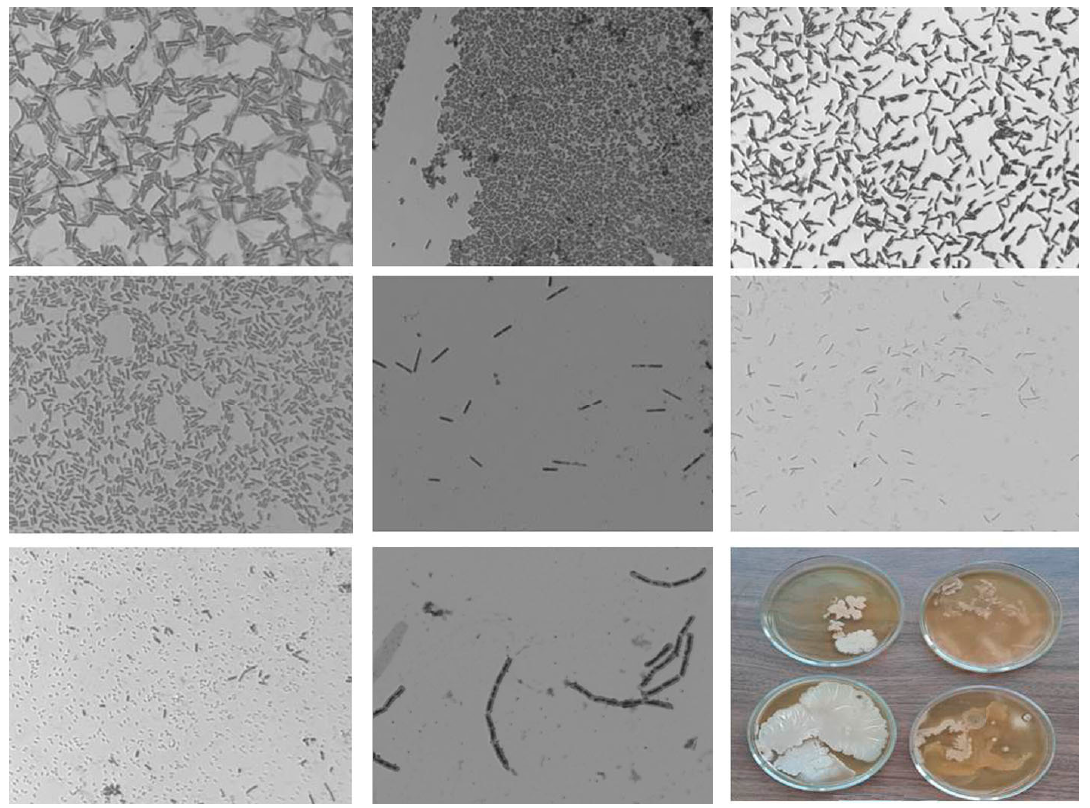
Figure 2. Photos of bacteria sown from control potato tubers (1000× zoom). The cell size in the control variant varied from 1.89 to 5.02 µ m in length and from 0.49 to 1.26 µ m in width. Different species on a Petri dish with MP mostly grew separately from each other, without competition. Visually, some cultures in the control were morpholog- ically similar to bacteria of the genera Geobacillus , Gammaproteobacteria , Bacillus ssp., and Bacillus subtilis.